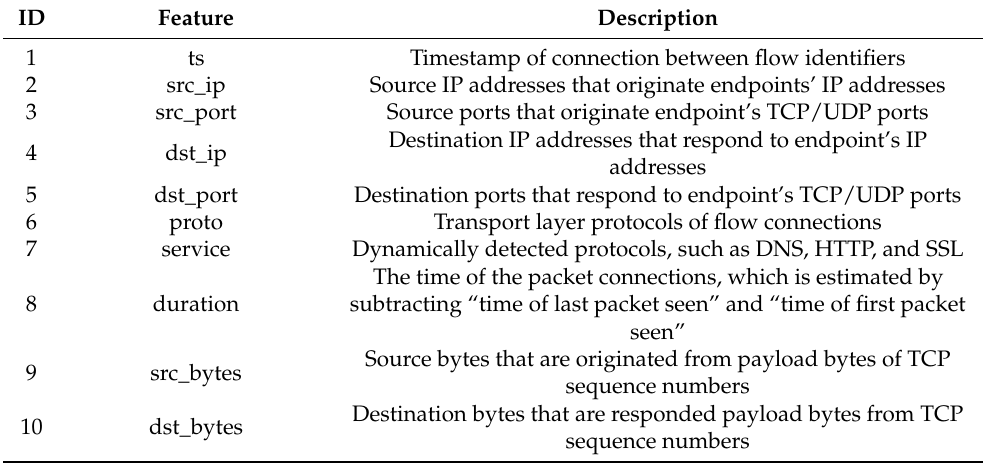
Table 3. Features and respective descriptions of the “Train_Test Network”